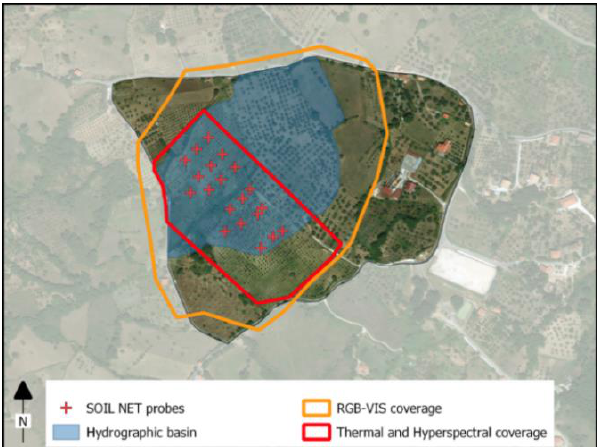
Figure 8. Map of the MFC2-Alento catchment. Red crosses indicate the locations of SoilNet sensors installed at soil depths of 15 and 30 cm. The positions of the SoilNet sensors correspond to soil sampling locations. The RGB-VIS coverage area is 18 ha, and the thermal and hyperspectral coverage area is 7.5 ha.